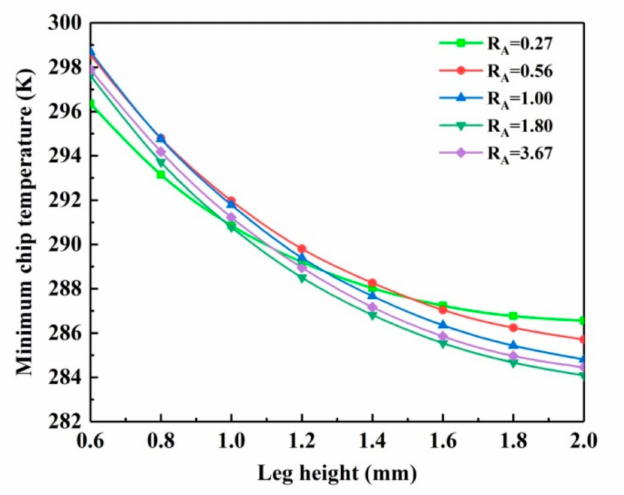
Figure 6. Variation of the minimum chip temperature with leg height for di ff erent R A